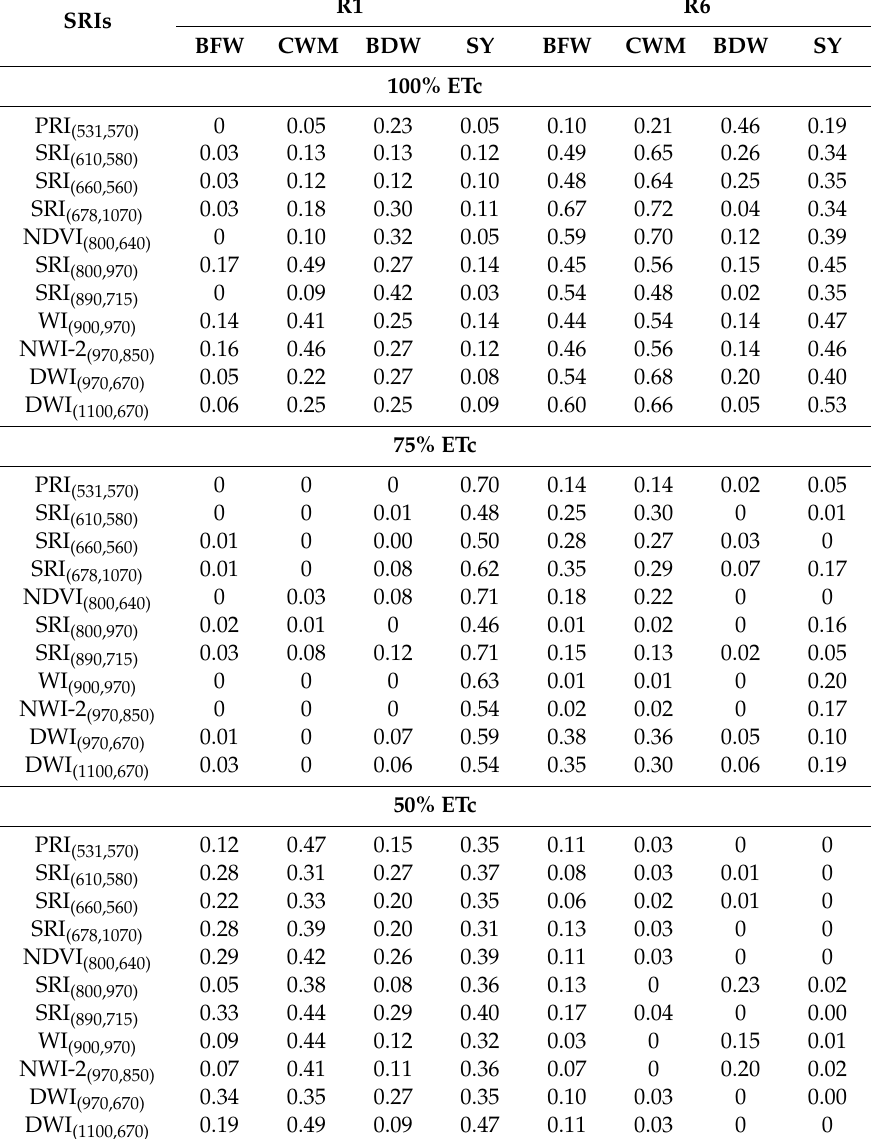
Table 5. Determination coe ffi cients (R 2 ) for the relationship between di ff erent spectral reflectance indices (SRIs) and vegetative growth traits (biomass fresh weight (BFW), biomass dry weight (BDW), canopy water mass (CWM), and seed yield (SY)) for each irrigation regime at each growth stage ( n = 8): R1 and R6 indicate the beginning bloom and full seed growth stages,